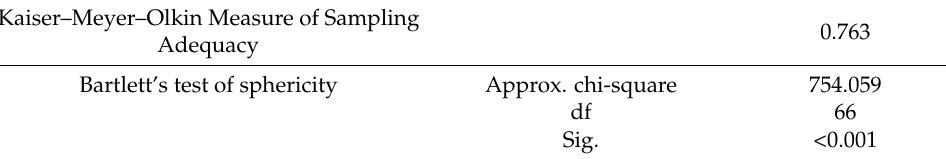
Table 9. KMO and Bartlett’s test